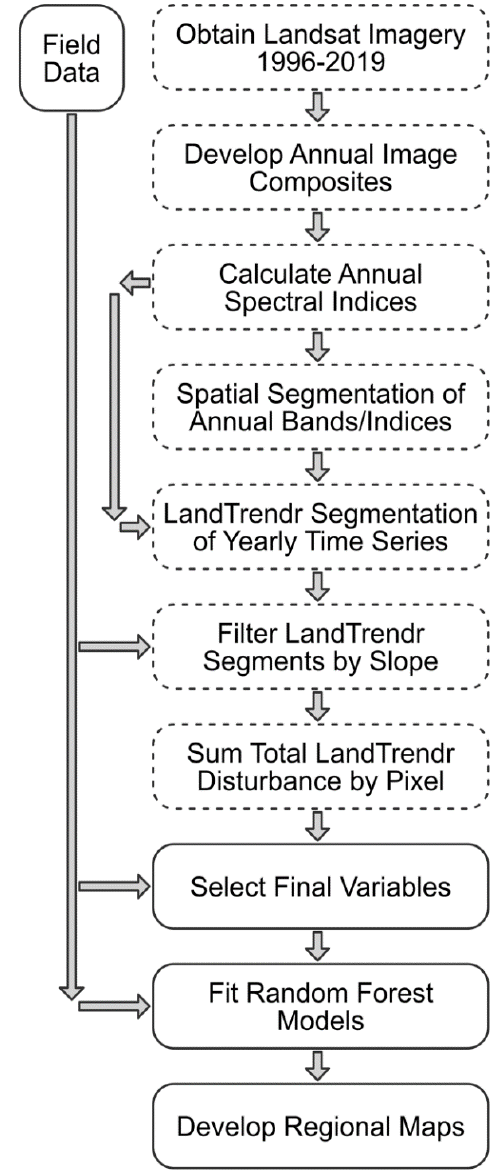
Figure 2. Flowchart of image processing and statistical modeling steps involved in developing regional maps of the presence and severity of bark beetle attack in the SRM. Steps performed in Google Earth Engine [60] are represented with dashed boxes, and steps performed in the R environment [61] are represented with solid boxes. LandTrendr (Landsat-based detection of trends in disturbance and recovery) is a pixel-based temporal segmentation algorithm used to identify homogeneous periods of spectral increase, stability, and decline [62,63].